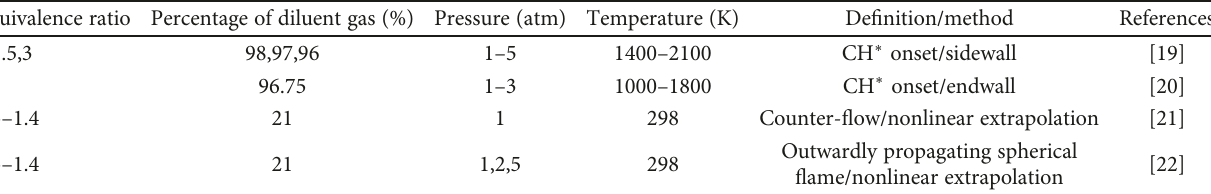
Table 2: Experimental data of ignition delay time and fl ame propagation speed under certain